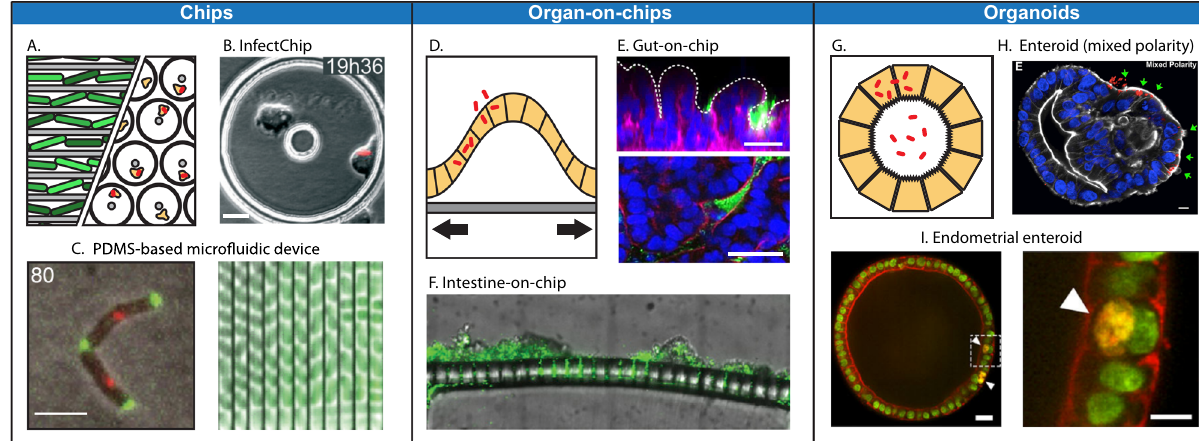
Fig. 3 Innovative platforms (chips, organs-on-chips and organoids) recently used to dissect the infection process. A Schematic diagram of chips containing bacteria or infected cells. B InfectChip containing two cells of the D. discoideum species, one of them infected with mCherry expressing M. marinum (scale bar = 10 μ m, modi fi ed from Delincé et al. 54 ). C PDMS-based micro fl uidic devices for the single-cell analysis of bacteria. (Left) M. smegmatis expressing Wag31-GFP to label the bacterial septum and mCherry-DnaN to mark the DNA replisome complex, cultured in a micro fl uidic chip (scale bar = 3 μ m, modi fi ed from Santi et al. 97 ). (Right) S . Typhimurium expressing GFP under control of the promoter sicA to assess T3SS-1 activity under exposure of antibiotics grown on a micro fl uidic device over time (x axis) for single-cell analysis (modi fi ed from Arnoldini et al. 98 ). D Schematic diagram of organ-on-chip infected with bacteria. E E. coli expressing GFP infecting epithelial cells on a gut-on-chip (upper panel, vertical cross-section; bottom panel horizontal cross-section, scale bar = 50 μ m) showing F-actin in magenta and nuclei in blue (modi fi ed from Kim et al. 99 ). F Frontal cross-section of an intestine-on-chip infected with S. fl exneri expressing GFP (modi fi ed from Grassart et al. 56 ). G Schematic diagram of organoids infected with bacteria. H S . Typhimurium expressing mCherry infecting the apical surface of an enteroid with mixed epithelial polarity (actin in white, nuclei in blue, scale bar = 10 μ m, modi fi ed from Co et al. 61 ). I (Left) Murine endometrial organoid infected with C. trachomatis expressing mCherry (actin in red, DNA i green, scale bar = 40 μ m, modi fi ed from Bishop et al. 100 ). (Right). Higher magni fi cation of boxed area shown in J (scale bar = 20 μ